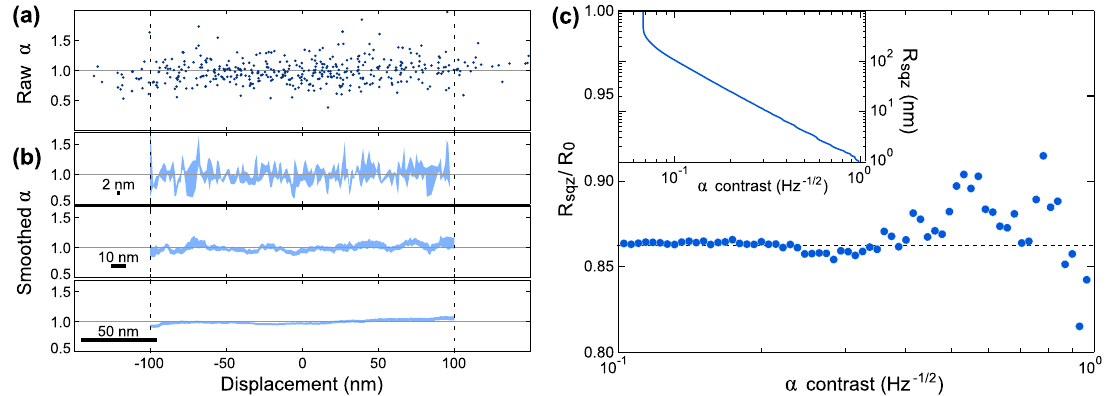
FIG. 3 (color online). Characterization of the spatial resolution. To calibrate the resolution enhancement achieved here, a profile of α ð x Þ is constructed by tracking particles in water. The individual measurements are shown in (a), while (b) shows the corresponding moving mean and standard error calculated over a 200-nm range with spatial resolution of 2, 10, and 50 nm. The data closely follow the expected α ¼ 1 result (horizontal line). (c), The ratio of spatial resolutions with squeezed and coherent light is shown as a function of contrast in α . The α contrast values shown are normalized into units of Hz − 1 = 2 to account for the improvement in absolute contrast as data are accumulated. For a fixed contrast, the spatial resolution achievable with squeezing ( R ) is improved by approximately 14% sqz when compared to coherent light ( R 0 ). The absolute spatial resolution achievable using squeezed light is plotted in the inset. Since the number of points being averaged is proportional to the spatial resolution, the sensitivity scales as the inverse square root of spatial resolution until the averaging window width becomes comparable to the spatial range of the measured